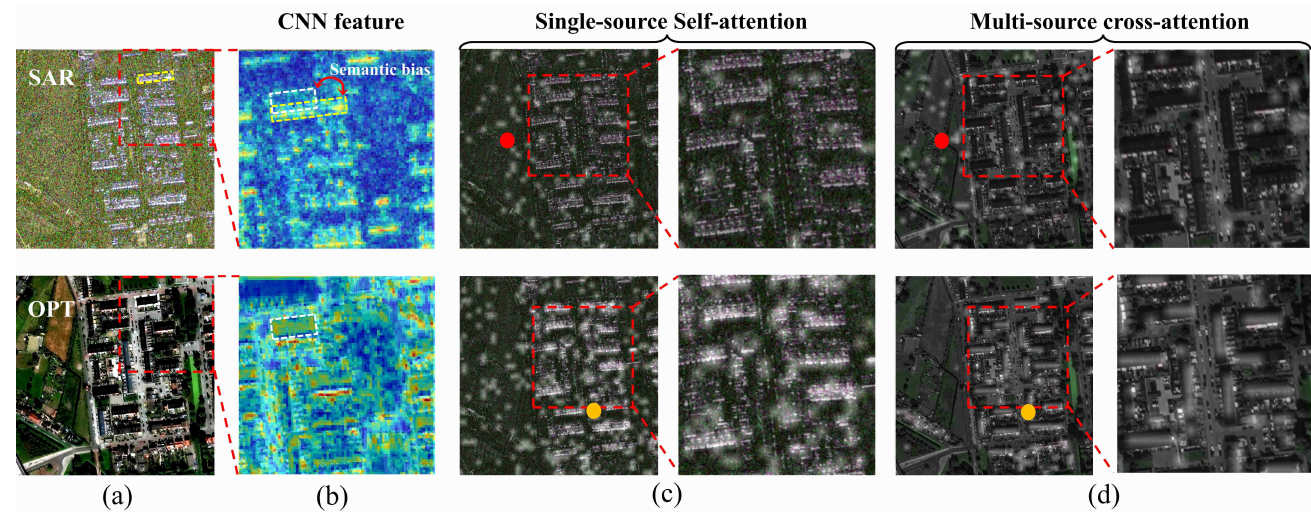
Figure 1. Limitation of direct pixel-wise fusion and advantages of the MsIFT in addressing mis- aligement by global receptive fields. ( a ) Synthetic aperture radar (SAR) image and optical (OPT) image. ( b ) CNN features of multi-source images. ( c ) Attention maps of the picked spatial points from SAR image during feature extraction. ( d ) Attention maps of the picked spatial points from the optical image during feature fusion. The brighter region indicates the area that the query points pay more attention to. As shown in ( c , d ), the red background query points pay more attention to the background region, while the yellow object query points pay more attention to the objects’ region. The query will aggregate the features on the attention region at the feature extraction and fusion stage. Therefore, the MsIFT is powerful in overcoming the semantic bias caused by the misaligned multi-source